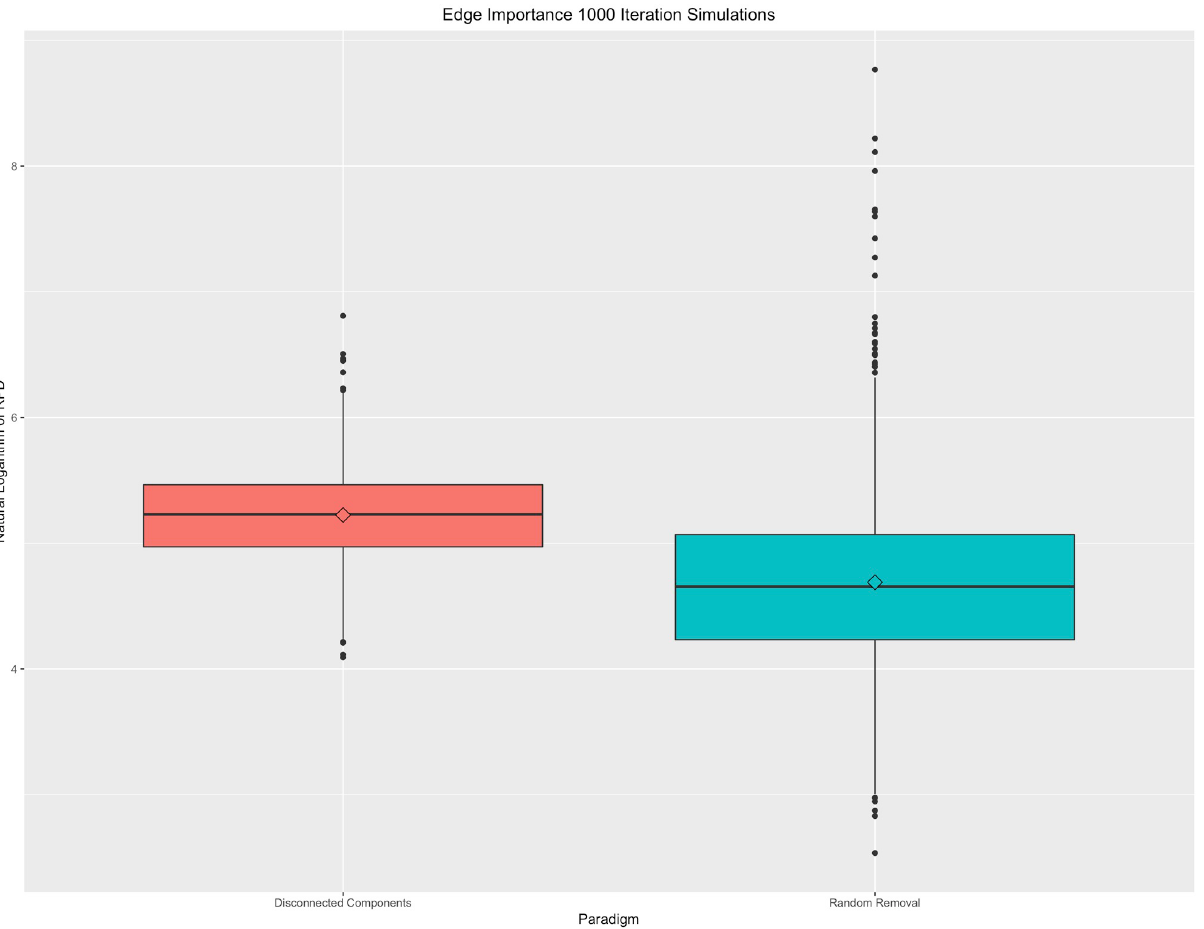
Fig 2. Edge importance property. Boxplot of 1000 iterations under targeted deletions resulting in disconnected components and equally-numbered, but random, deletions. A natural logarithm transformation has been applied to all resistance perturbation distance values for this figure. While random deletions result in a wider overall spread of distances, targeted deletions result, on average, in a larger RPD than a comparable random deletion.